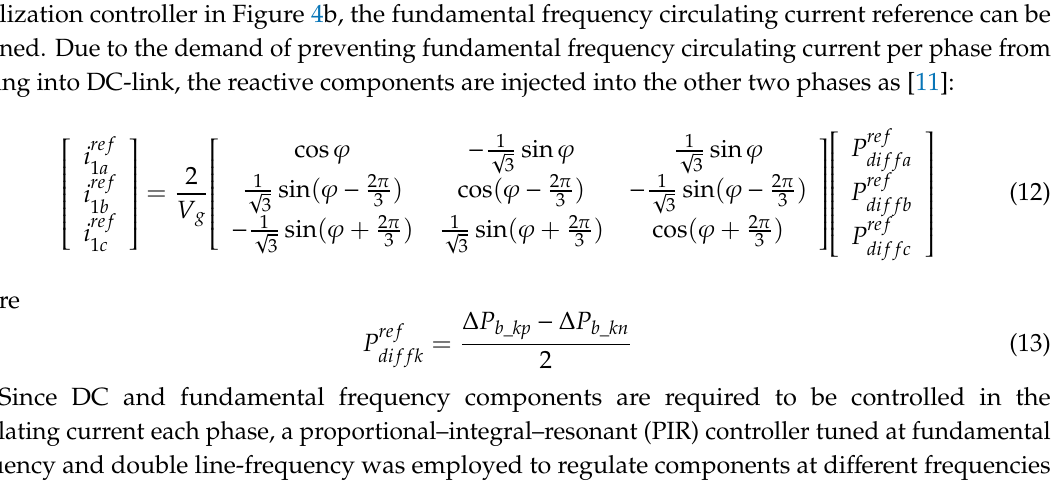
Figure 6. DC-link voltage control diagram.